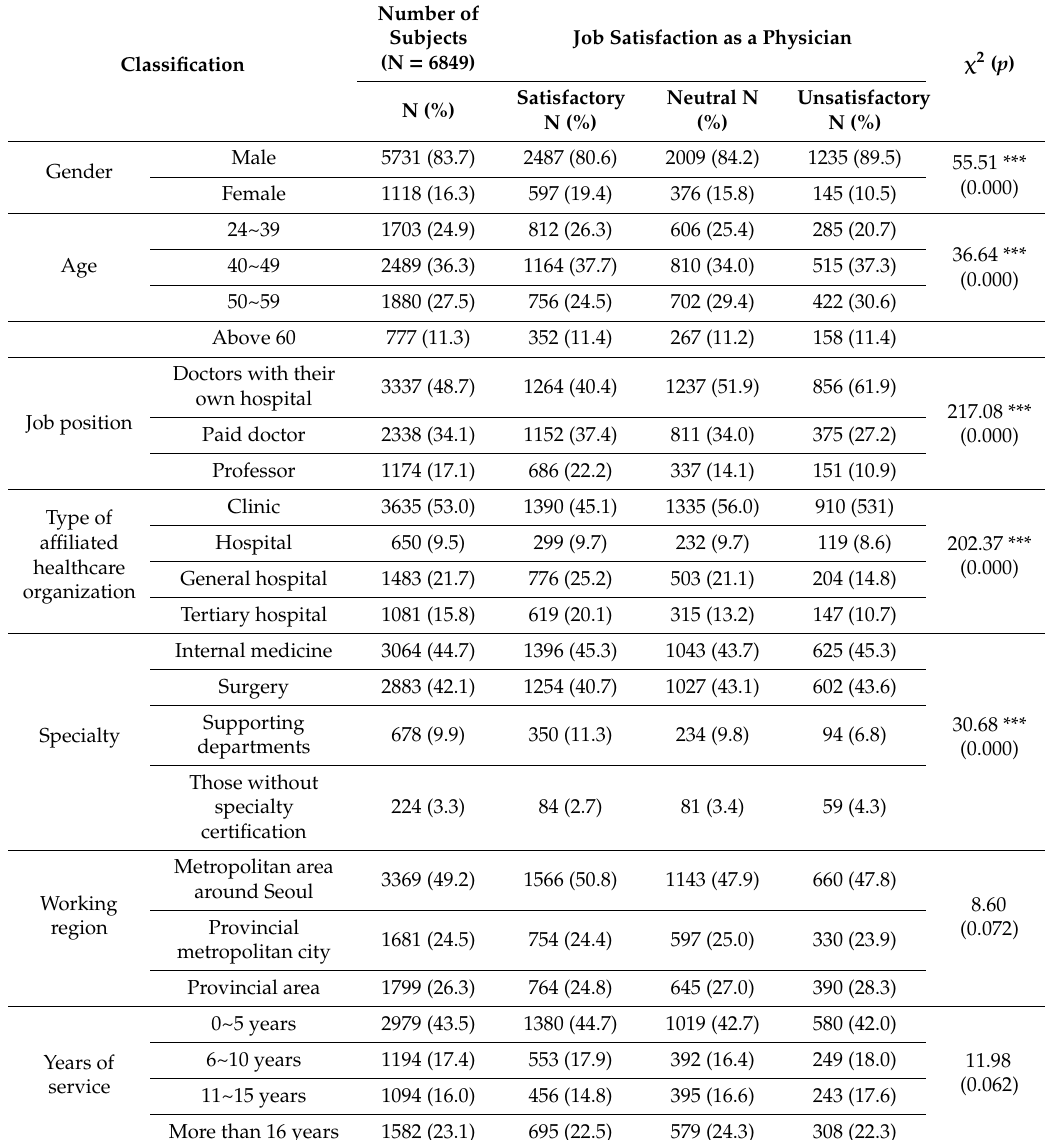
Table 2. The distribution and Chi-square of general